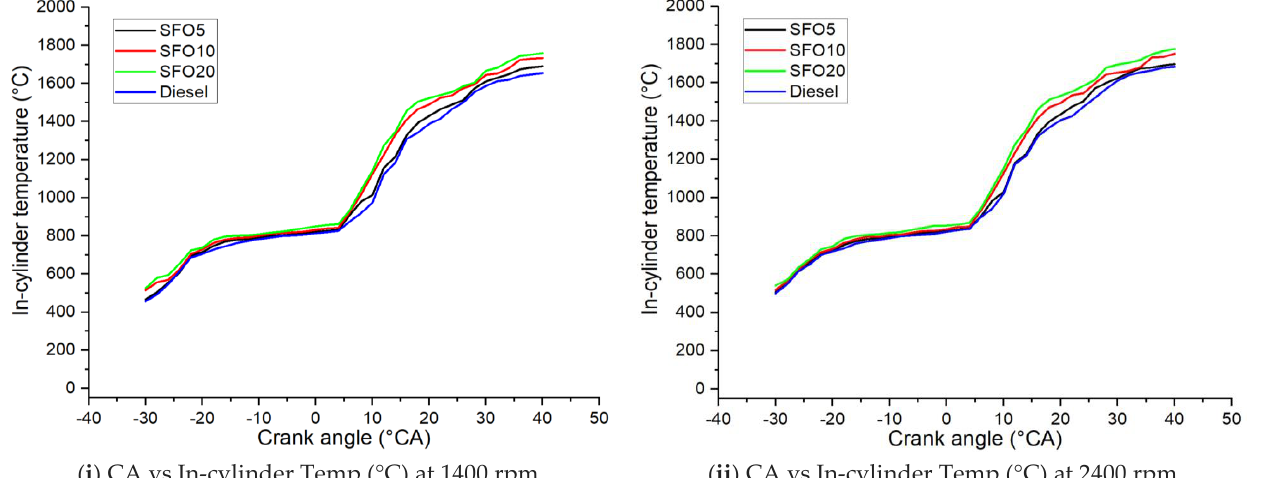
Figure 10. The variations in in-cylinder temperature for SFO blends and diesel under 100% engine load at speeds of ( i ) 1400 rpm and ( ii ) 2400 rpm.